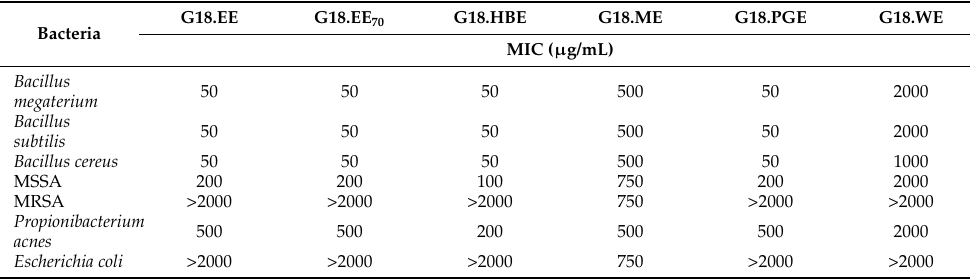
Table 2. MIC values ( µ g/mL) obtained against the panel of susceptibility indicator bacteria. Mid- exponential phase microbial cultures were transferred to plates supplemented with increasing con- centrations of each of the six extracts—G18.EE, G18.EE 70 , G18.HBE, G18.ME, G18.PGE and G18.WE. Plates were observed for the presence/absence of growth after 24 h incubation at 37 ◦ C, and the lowest concentrations for which no growth was detected were registered as the MIC